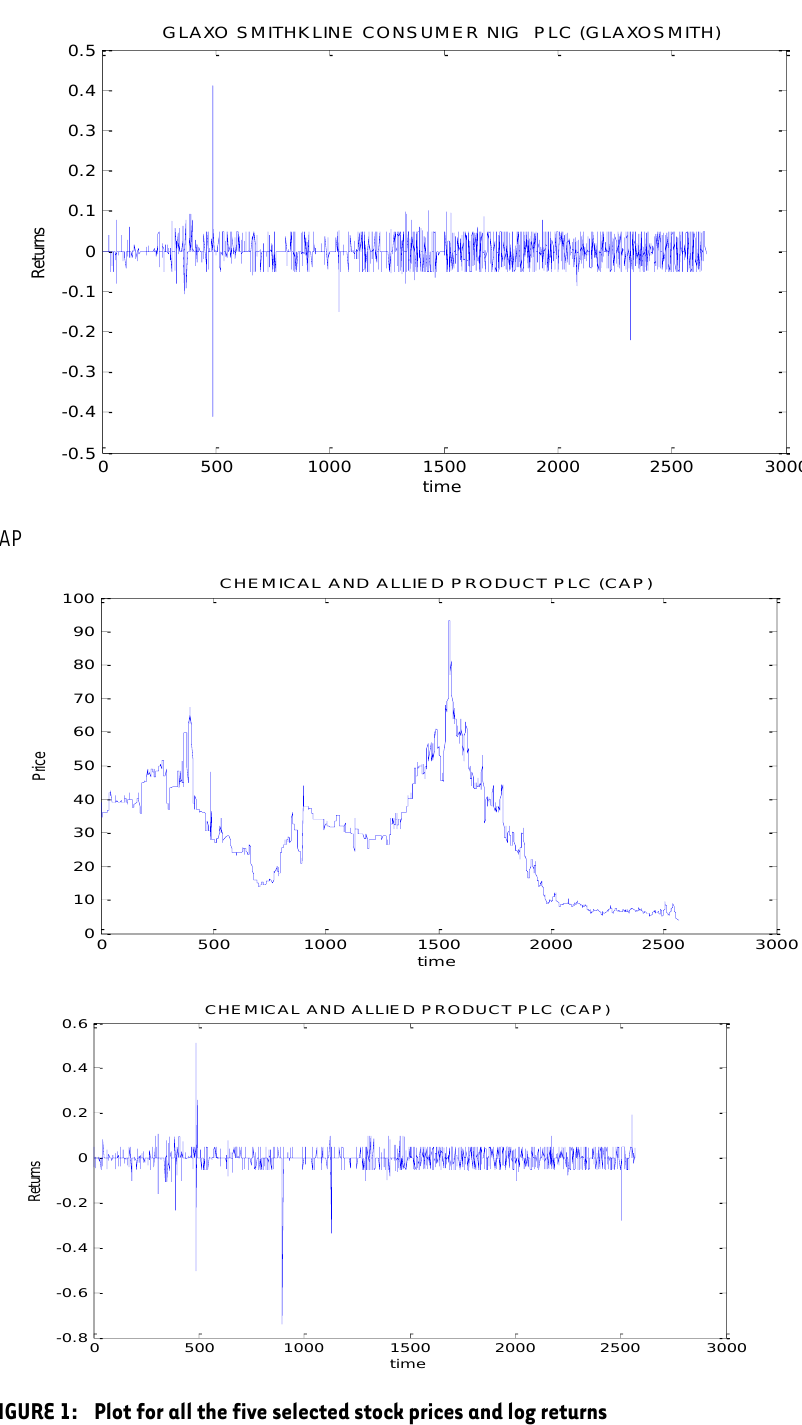
FIGURE 1: Plot for all the five selected stock prices and log